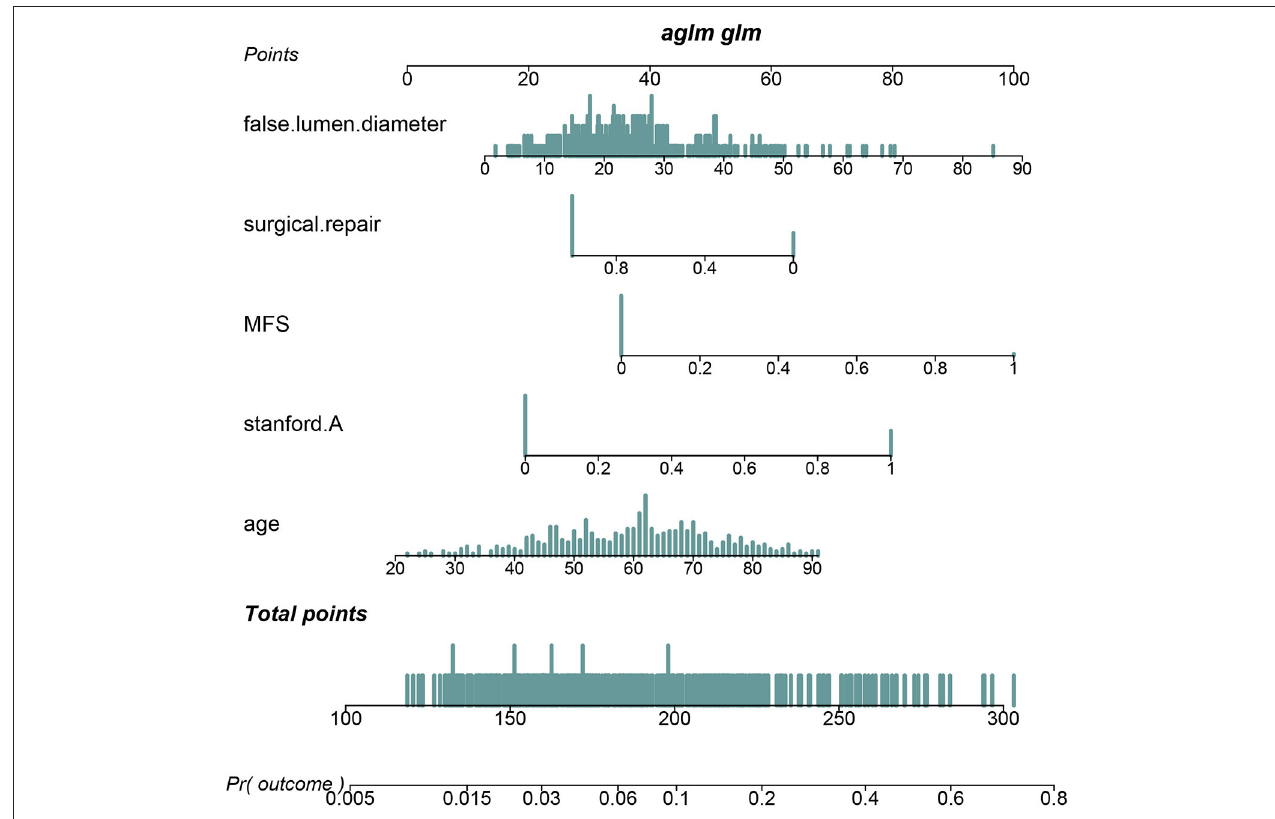
FIGURE 1 | A nomogram for predicting the in-hospital prognosis of patients with AAD.